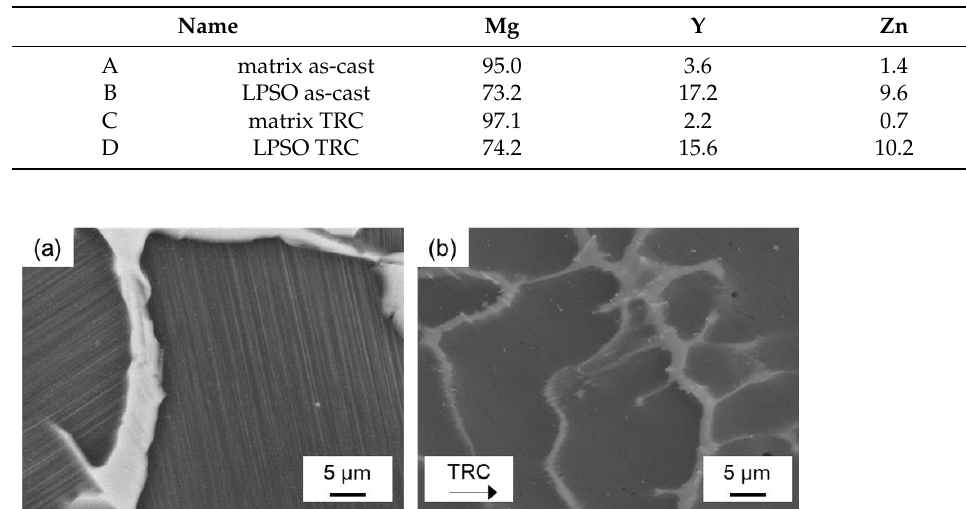
Figure 3. Results of the X-ray diffraction analysis (XRD) of the homogenized (500 ◦ C, 2 h) Mg-6.8Y- 2.5Zn-0.4Zr alloy after conventional and after twin-roll casting. Table 2. Chemical composition of microstructural constituents from the as-cast and the TRC condition in Figure 2 (A, C—magnesium matrix, B, D—network-like LPSO structures) determined by means of energy dispersive X-ray spectroscopy (EDX)-analysis (wt.%).